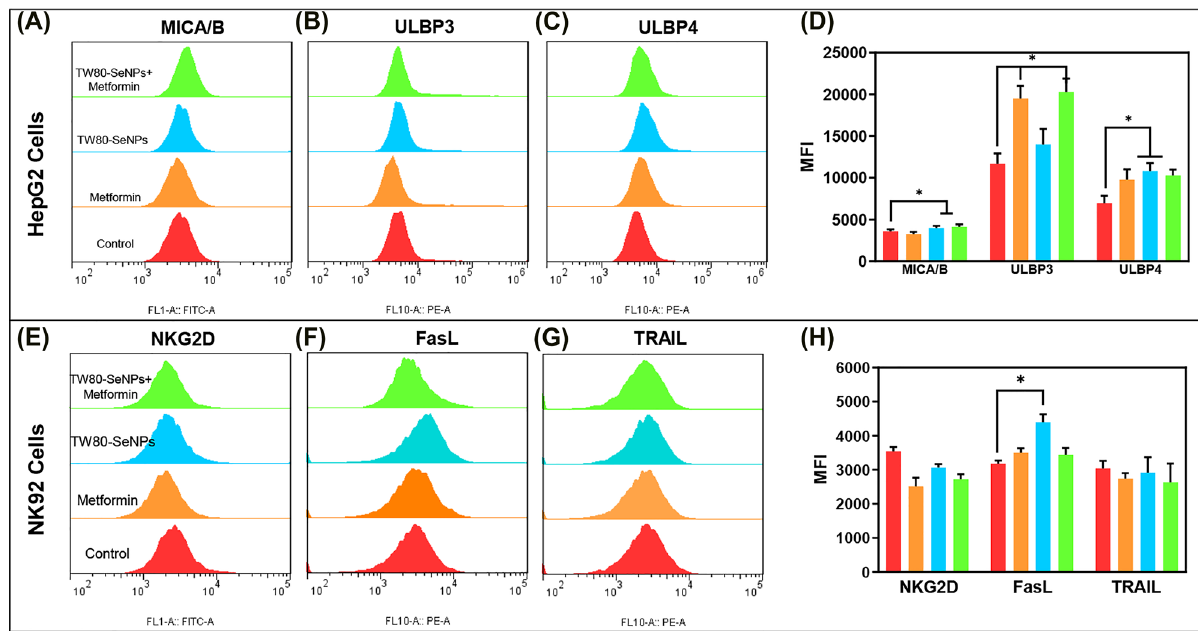
Figure 3: The expression levels of receptor signaling molecule on HepG2 cells and NK92 cells after treatment with TW80-SeNPs combined with met for 24 h. (A) MICA/B, (B) ULBP3 and (C) ULBP4, (D) the MFI value of each receptor signaling molecule on HepG2 cells, (E) NKG2D, (F) FasL and (G)